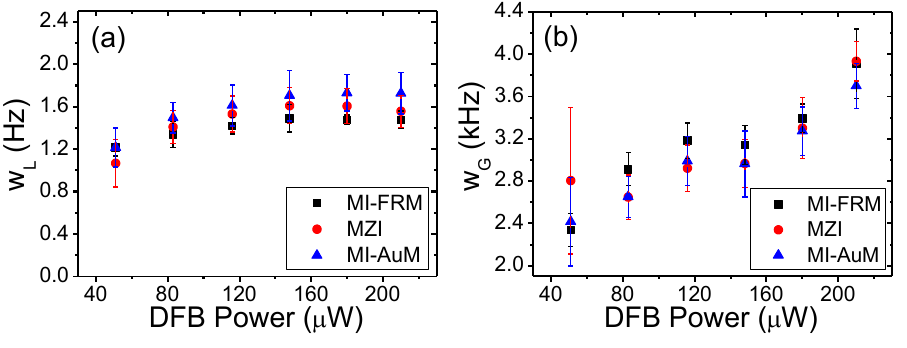
Figure 4. ( a ) Lorentzian, w fitting of each measurement taken for the MZI and